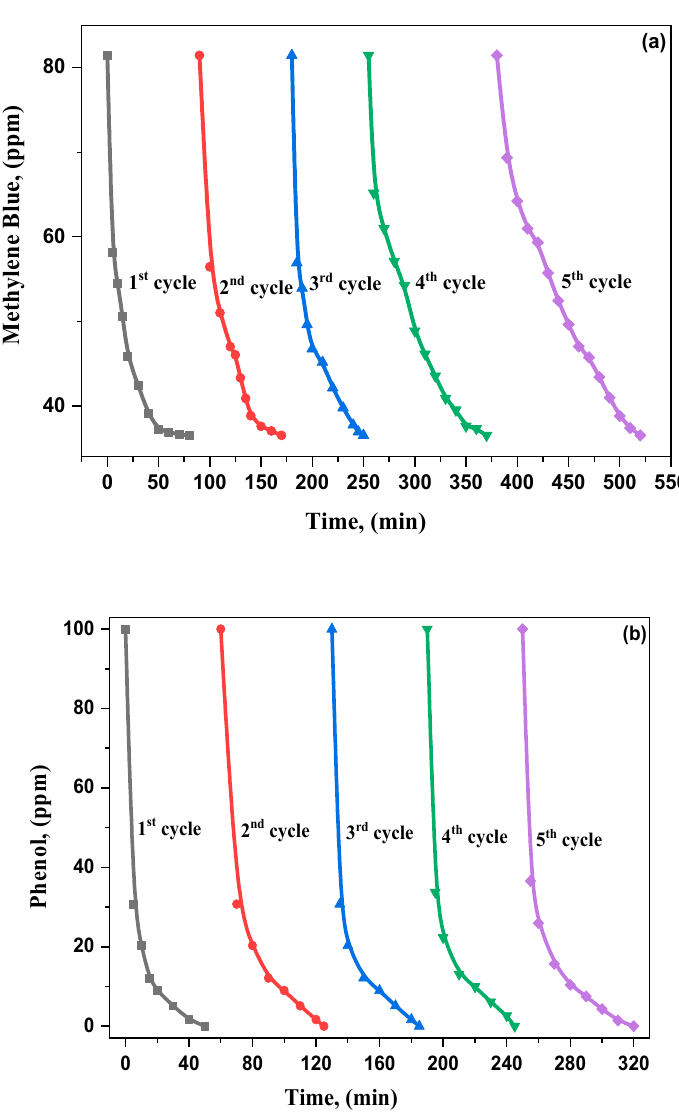
Figure 11. ( a , b ) Recycling data for photodegradation in the presence of ( a ) 0.5 g Eu-doped ZnO (S4) of MB; ( b ) 1 g Eu-doped ZnO (S5) of